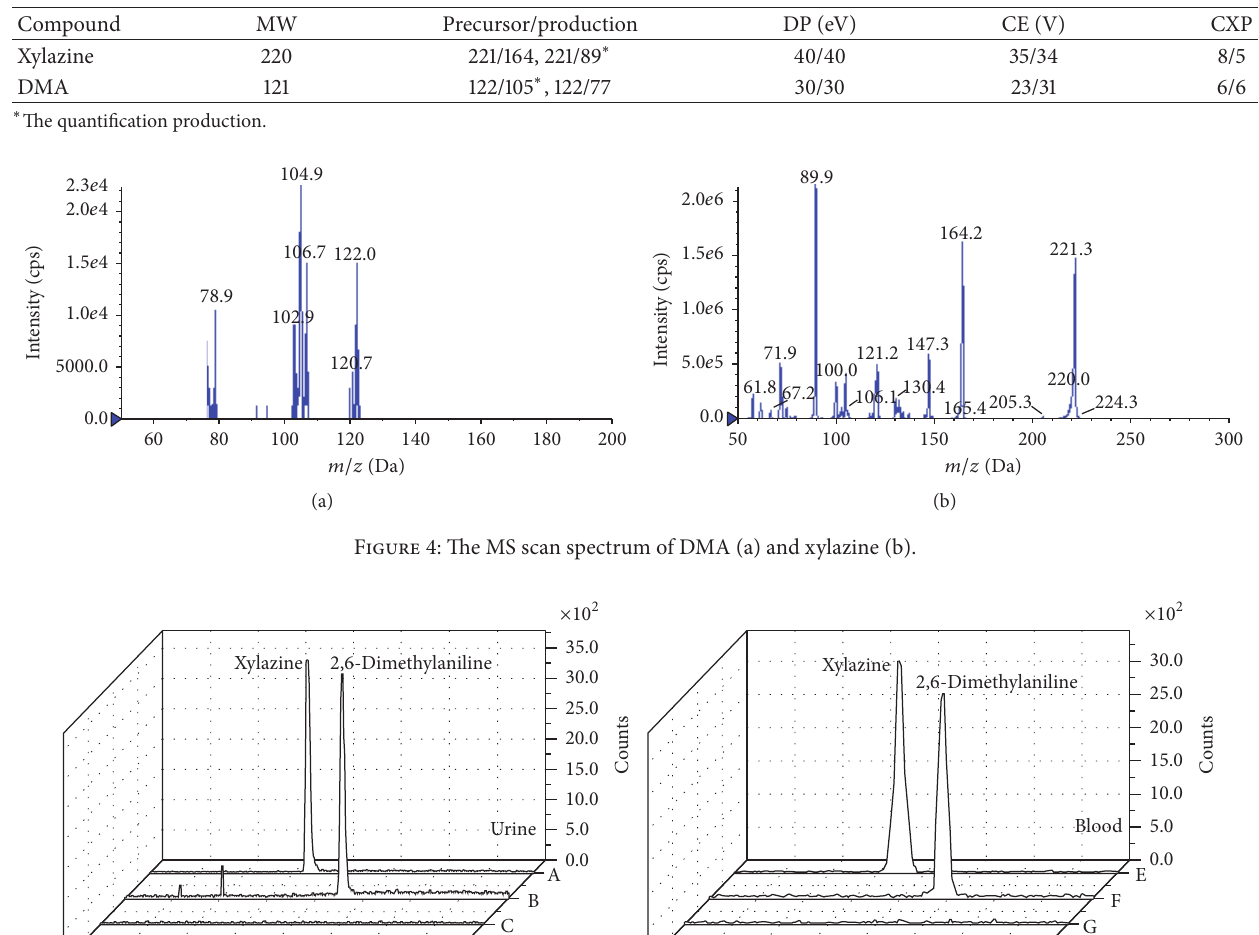
Table 1: MS parameters of xylazine and DMA.